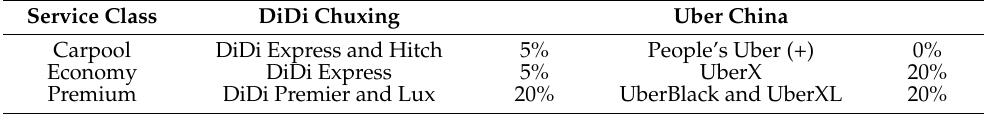
Table 4. Comparisons of platform service fee rates